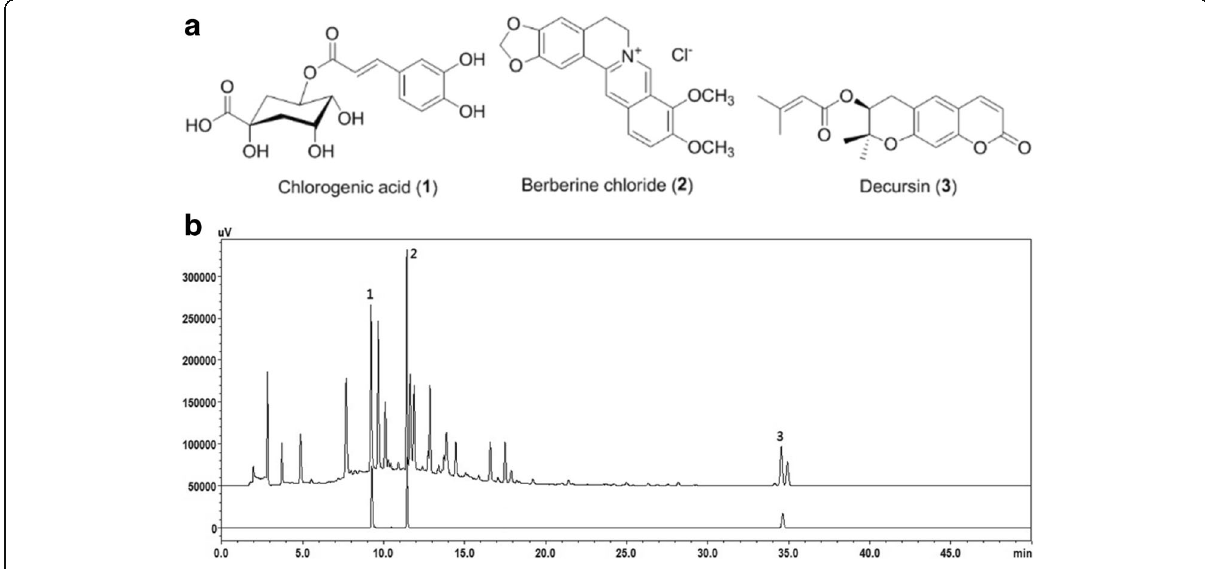
Fig. 1 a Chemical structures of compounds 1 – 3; b HPLC chromatogram of a standard solution and ChondroT, with detection at 330 nm. (1) Chlorogenic acid, (2) berberine Cl, and (3)